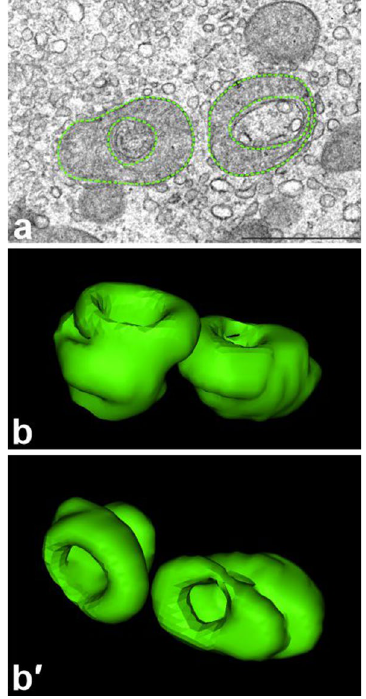
Figure 5. Goblet-shaped mitochondria. ( a ) Transverse section through two “circular” mitochondria; their outlines (external and internal) are marked with green dots. Bar represents 2 µm. ( b , b ′ ) 3D reconstruction of the same mitochondria as seen from two different angles; “circular” organelles shown in ( a ) appeared to represent cross sections of goblet-shaped mitochondria. Three-dimensional reconstructions images were performed with the ImageJ Software (version 1.51 h), https:// imagej. nih. gov/